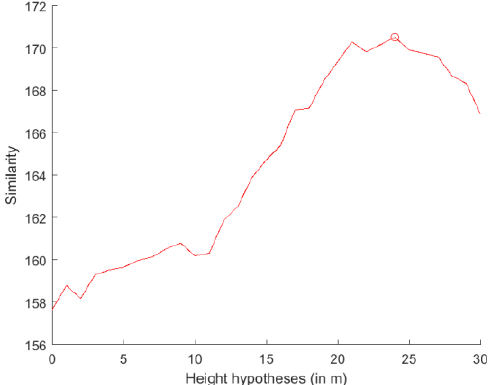
Figure 5. Similarity function of the height hypotheses from the search interval [0; 30]. The peak located at a height of 24m is marked with a circle.